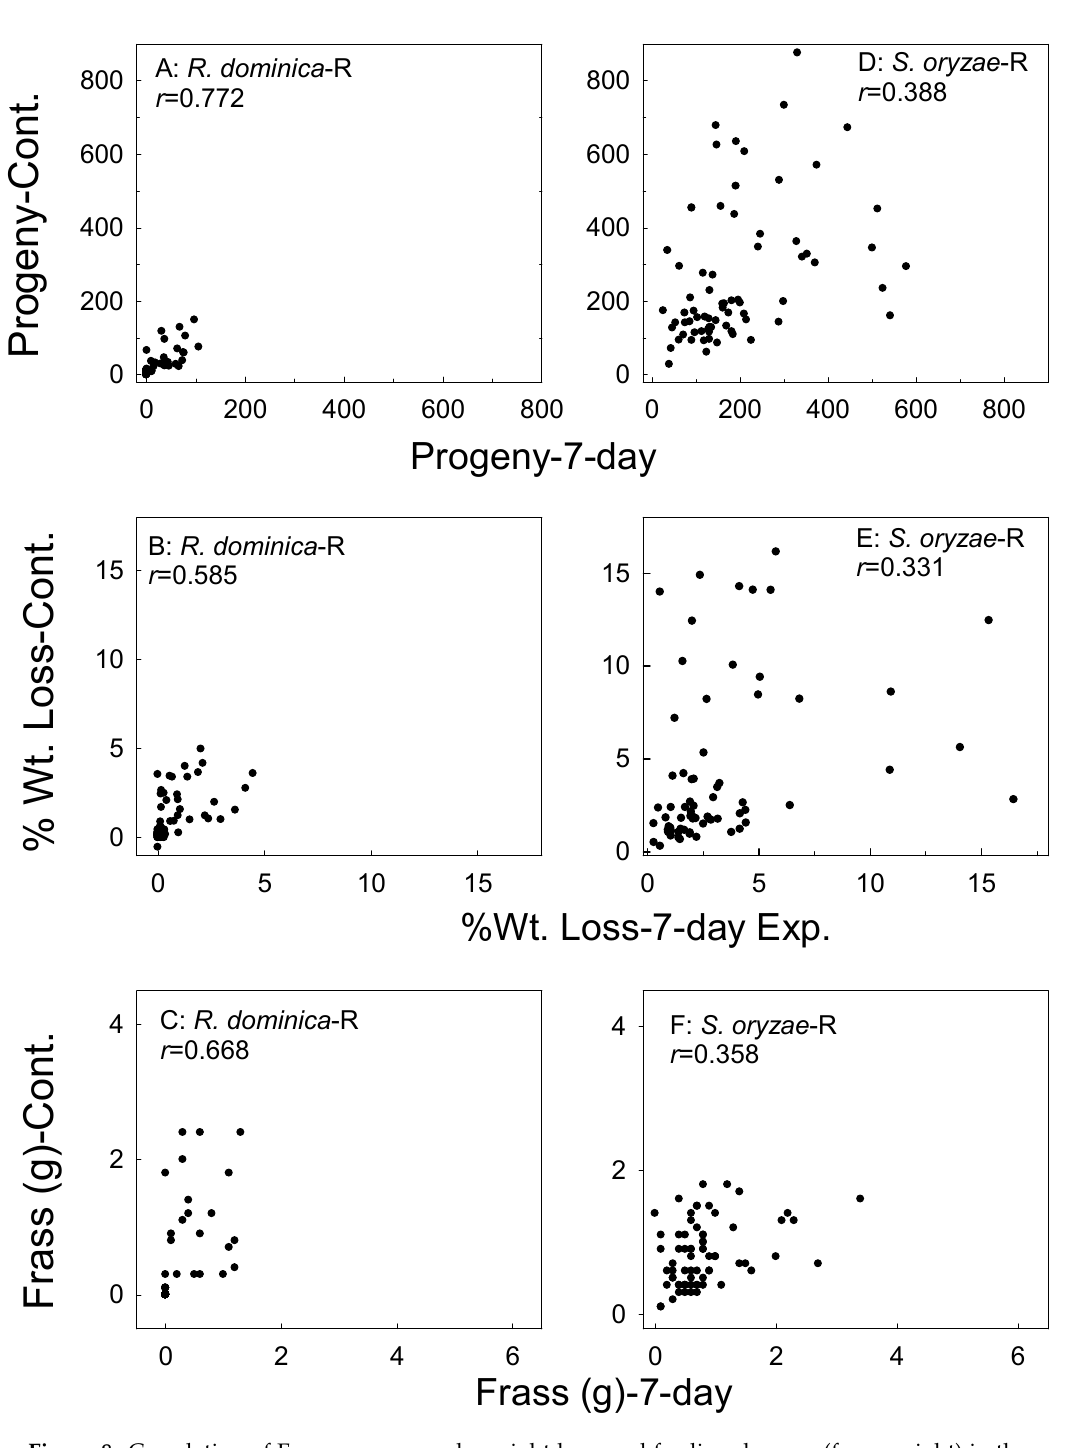
Figure 8. Correlation of F 1 progeny, sample weight loss, and feeding damage (frass weight) in the brown rice (R) samples whereby parental adults were exposed for 7 days versus the continual exposures of parental adults for R. dominica ( A – C ) and S. oryzae ( D – F ). Data combined for all treatments and all bioassay months.